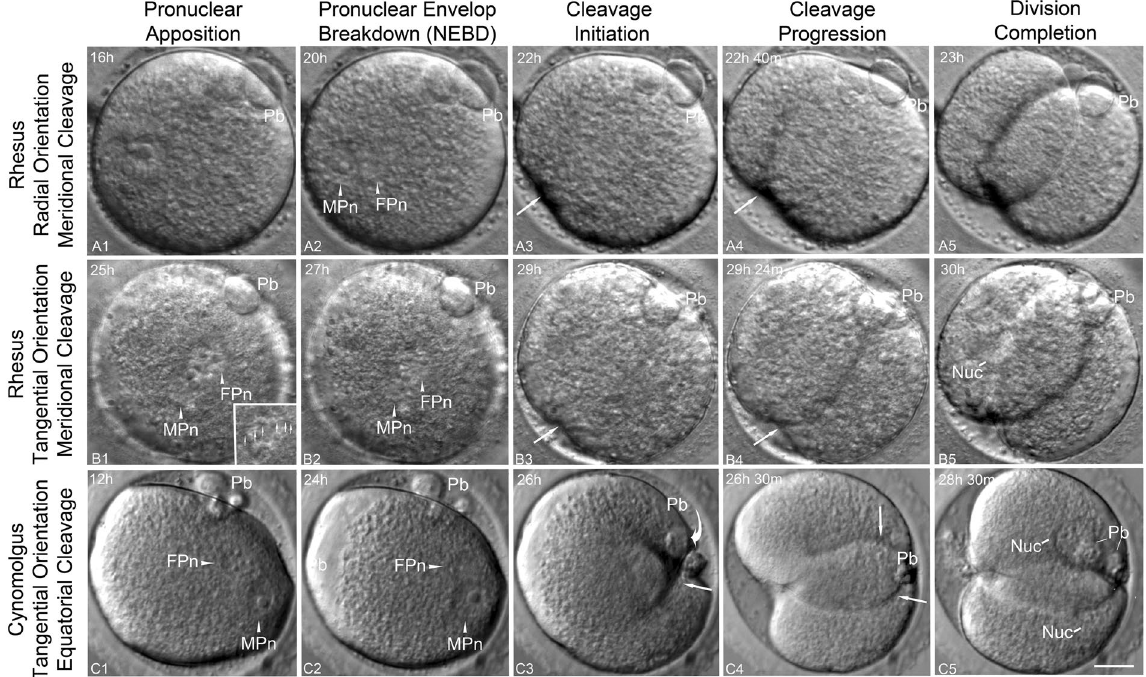
Figure 3. Cleavage furrow initiation and zygotic division in NHP zygotes with varying pronuclear orientations. ( A1 – A5) Rhesus zygote showing radially aligned apposed pronuclei with oblique orientation to the A → V axis 16 hrs post-ICSI ( A1 ; polar body, Pb). Female pronuclear breakdown occurs first, around 20 hrs post- ICSI ( A2 ). A meridional cleavage begins at the cortex overlying the site of the formerly intact MPn ( A3 : arrow), progressing asymmetrically through the cytoplasm to within 30° of the second polar body (Pb) on the opposing cortex ( A4 : arrow) 22 h post-ICSI. After division at 23 hrs post-ICSI, both Pb reside between the daughter blastomeres ( A5 ). ( B1 – B5) A rhesus zygote with para-tangentially aligned cortical parental genomes oriented along the A → V axis 25 hrs post-ICSI ( B1 ; polar body, Pb; inset, details of apposed pronucleus and the incorporated sperm axoneme, small arrows). At 27 hrs post-ICSI, pronuclear breakdown begins with the MPn ( B2 ; MPn). Cleavage furrow initiation ( B3 : arrow) begins at the cortex overlying the site of the formerly intact MPn, progressing quickly through a meridional plane that includes the second polar body ( B4 : Pb). Cytokinesis at 30 hrs post-ICSI creates equal-sized daughter blastomeres with the polar bodies residing between the cleaved cells ( B5 : Pb; Nuc: daughter cell nucleus). ( C1 – C5) A cynomolgus ICSI zygote at 12 hrs post-ICSI showing apposed parental genomes aligned para-tangentially to the cortex and obliquely to the A → V axis ( C1 ). The FPn undergoes breakdown first at 24 hrs post-ICSI ( C2 ). However, cleavage furrow initiation at 26 hrs post-ICSI moves in an equatorial direction or right angle to the A → V axis ( C3 , straight arrow) while cortical membrane flow rotates both polar bodies into the developing furrow ( C3 , Pb, curved arrow depicts rotation direction). The bifurcated cleavage furrow progresses towards the opposite cortex ( C4 ; arrows) as cytokinesis forms equal-sized daughter blastomeres with the polar bodies between daughter cells by 28.5 hrs post-ICSI ( C5 : polar bodies, Pb; Nuc: reconstituted daughter cell nuclei). All panels are HMC images taken from TLVM videos of ICSI fertilized zygotes undergoing first cleavage. Time in hours:minutes (h:m) post-ICSI. Bar = 20 μ m.